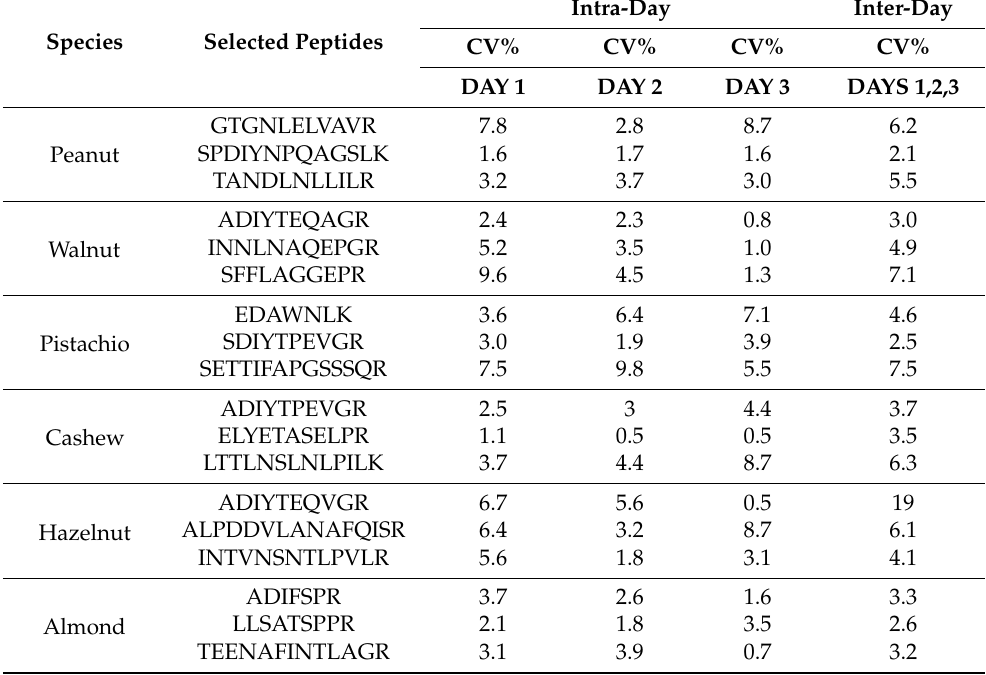
Table 7. Results of the evaluation of intra-day and inter-day precision for the developed method, based on the analysis of the tryptic digest of a protein extract corresponding to a cookie incurred with 50 mg · kg − 1 of each ingredient. Five LC-MS analysis replicates were performed during the same day on the same protein extract, for three consecutive days. The reported percentual coefficients of variation (CV%) were inferred from XIC peak areas for the selected